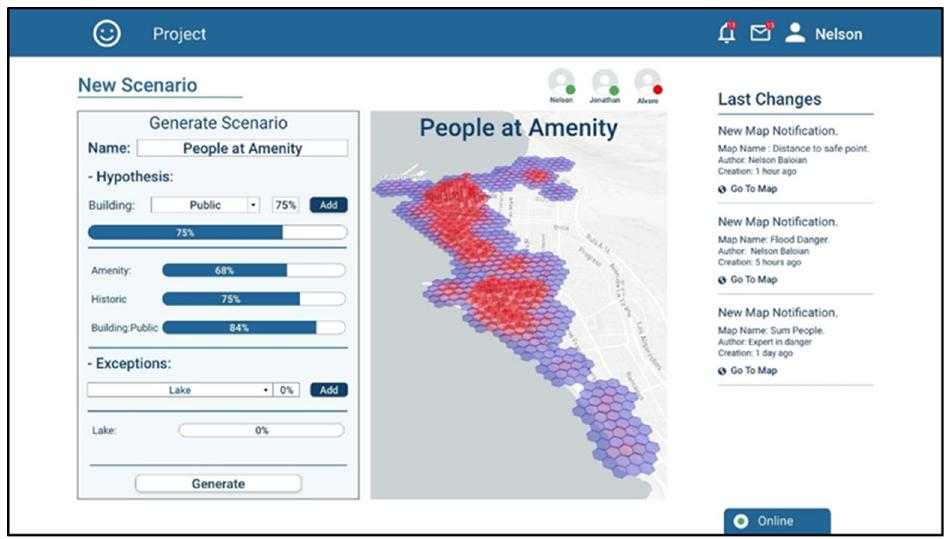
Figure 6. Screenshot of the application when generating a new map by defining hypotheses and their weights.